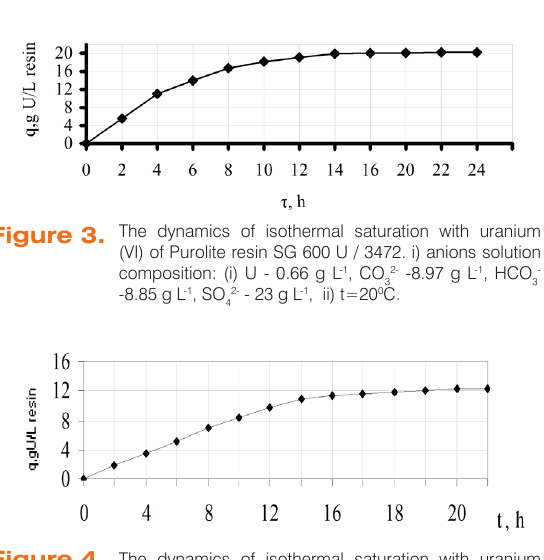
Figs. 1-4 show that with increasing of concentration of SO 42- in solution, the sorption equilibrium and the sorption dynamics relative to uranium (VI) are strongly affected.